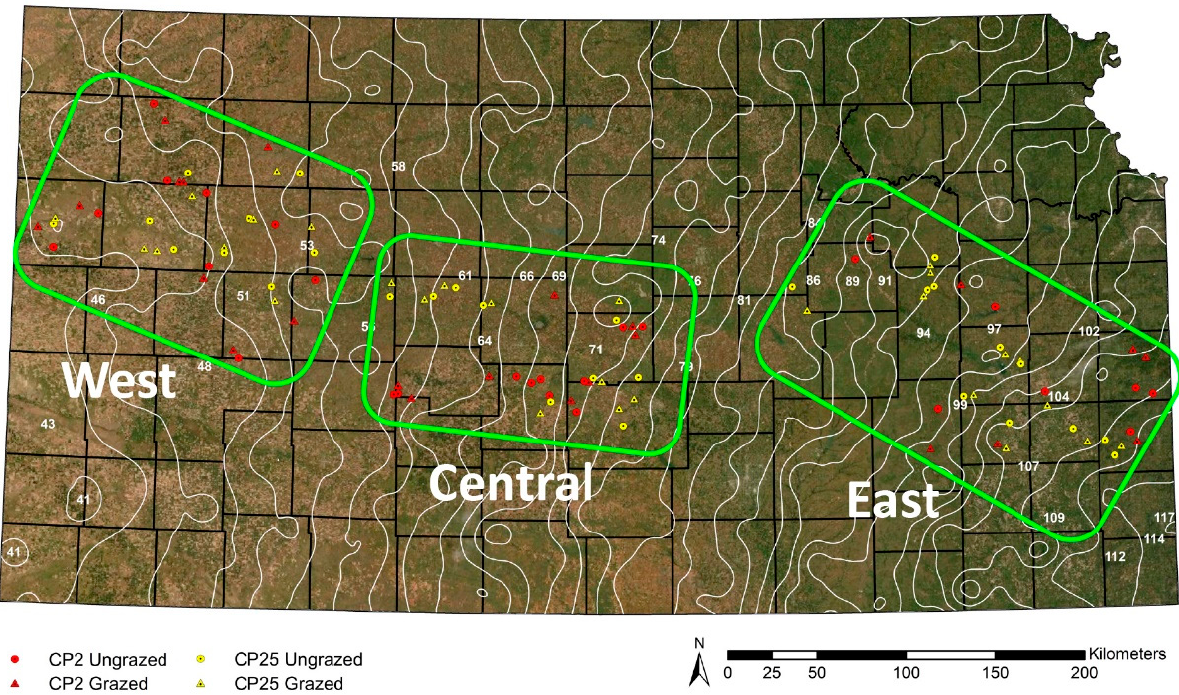
Figure 1. Map of Kansas with satellite image overlay [59] and the location of 108 CRP sites in this study. Background color depicts the precipitation gradient (drier in the west, wetter in the east) and changes in vegetation (short grassland in the west, tall grassland in the east). Red symbols represent CP2 restored sites (lower seed diversity restoration); yellow symbols represent CP25 restored sites (higher seed diversity restoration). Triangles are grazed sites; circles are ungrazed sites. The three study regions are represented by the green boxes (West, Central, East). White lines represent the 30-year average precipitation isoclines [56]. Image by Jackie Baum.